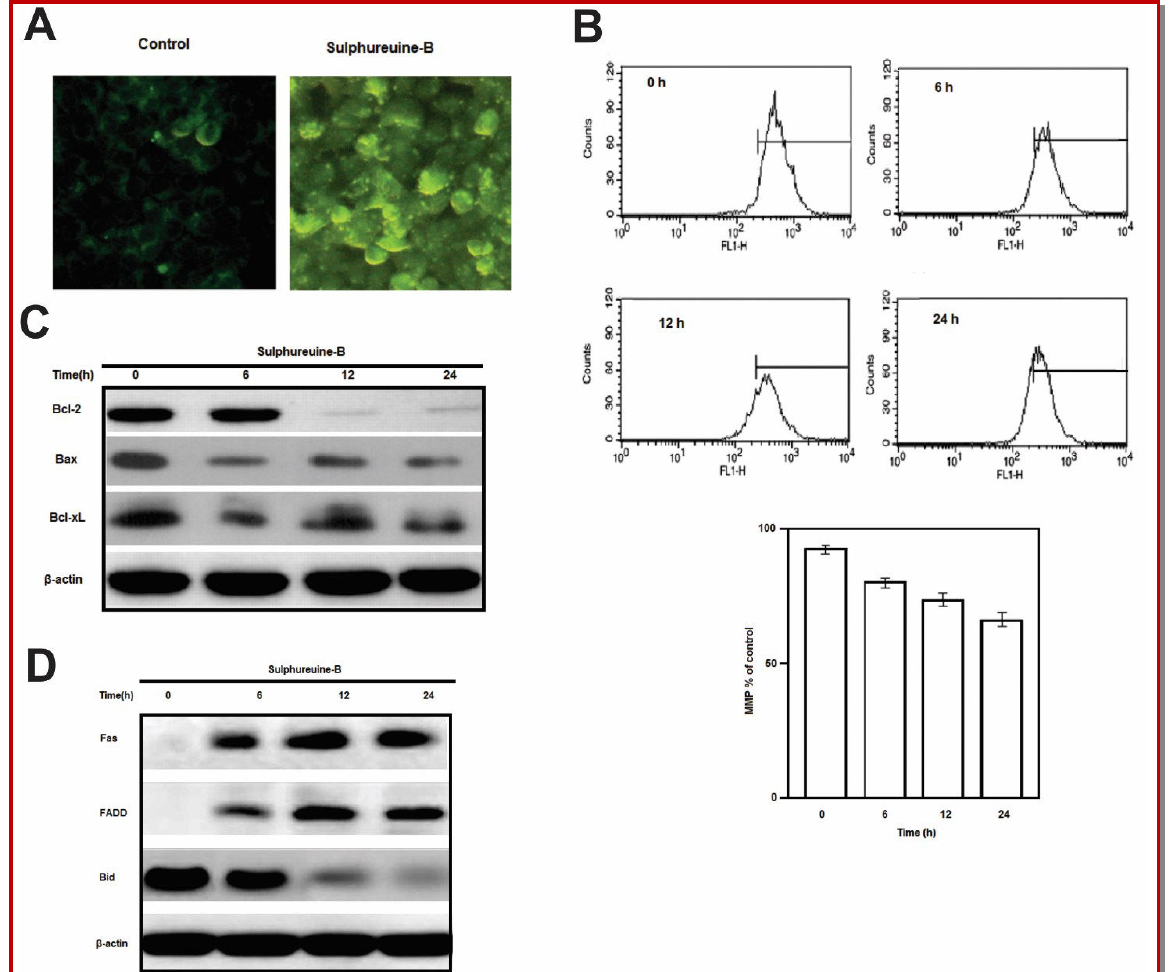
Figure 5 : A) Rhodamine 123 assay results upon treating U-87MG cells with 20 µM sulphureuine B for 24 hours; B) Mitochon- drial membrane potential results upon treating U-87MG cells with 20 µM sulphureuine B for about 6, 12 and 24 hours stained by Rhodamine 123; C) Western blot results upon treating U-87MG cells with 20 µM sulphureuine B to detect Bax/Bcl-2 ratio and Bcl-xl levels using β - actin as control; D) Immunoblotting results upon treating U-87MG cells with 20 µM sulphureuine B to detect Fas and FADD using β - actin as